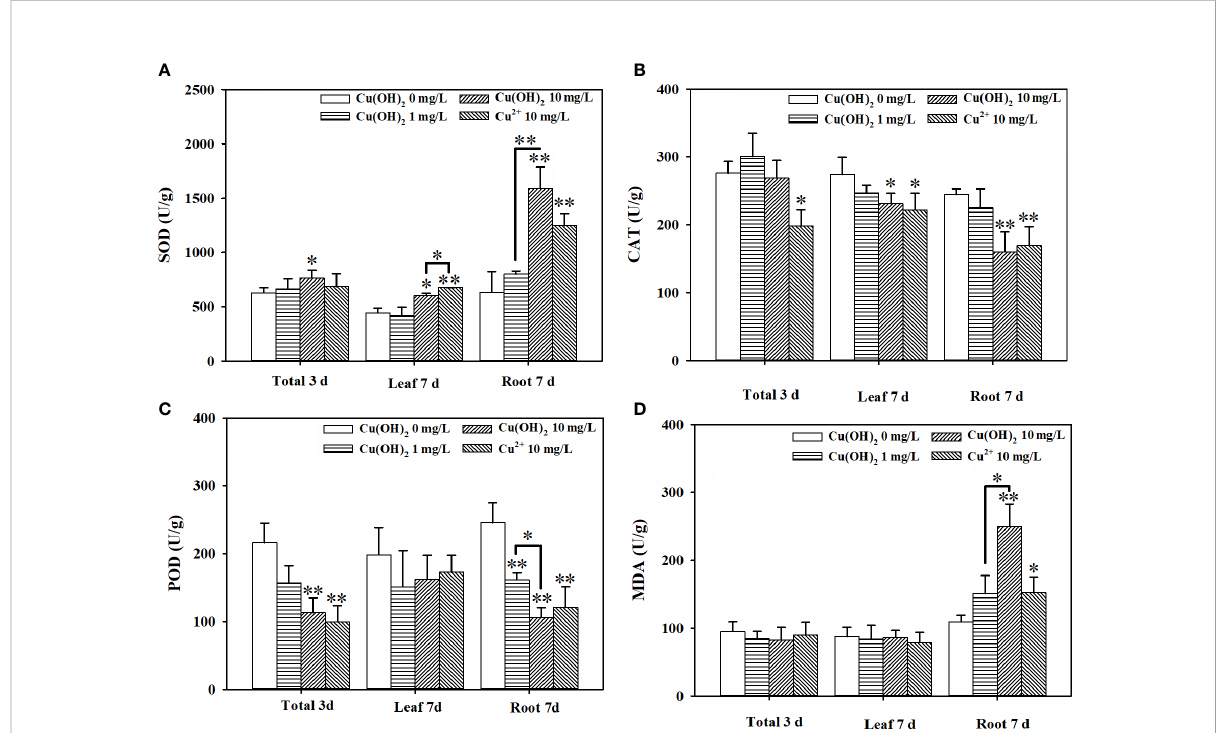
FIGURE 3 Effect of Cu(OH) 2 nanowire or Cu 2+ stress on the activities of SOD (A) , CAT (B) and POD (C) and level of MDA (D) in lettuce seed (3d) and in lettuce seedling leaves and roots (7d). The data are shown as the mean ± SD from the four replicates and were analyzed with a t test to explore any signi fi cant differences between treatment groups; asterisks * ( p < 0.05) and ** ( p < 0.01) denote statistical signi fi cance and high statistical signi fi cance,